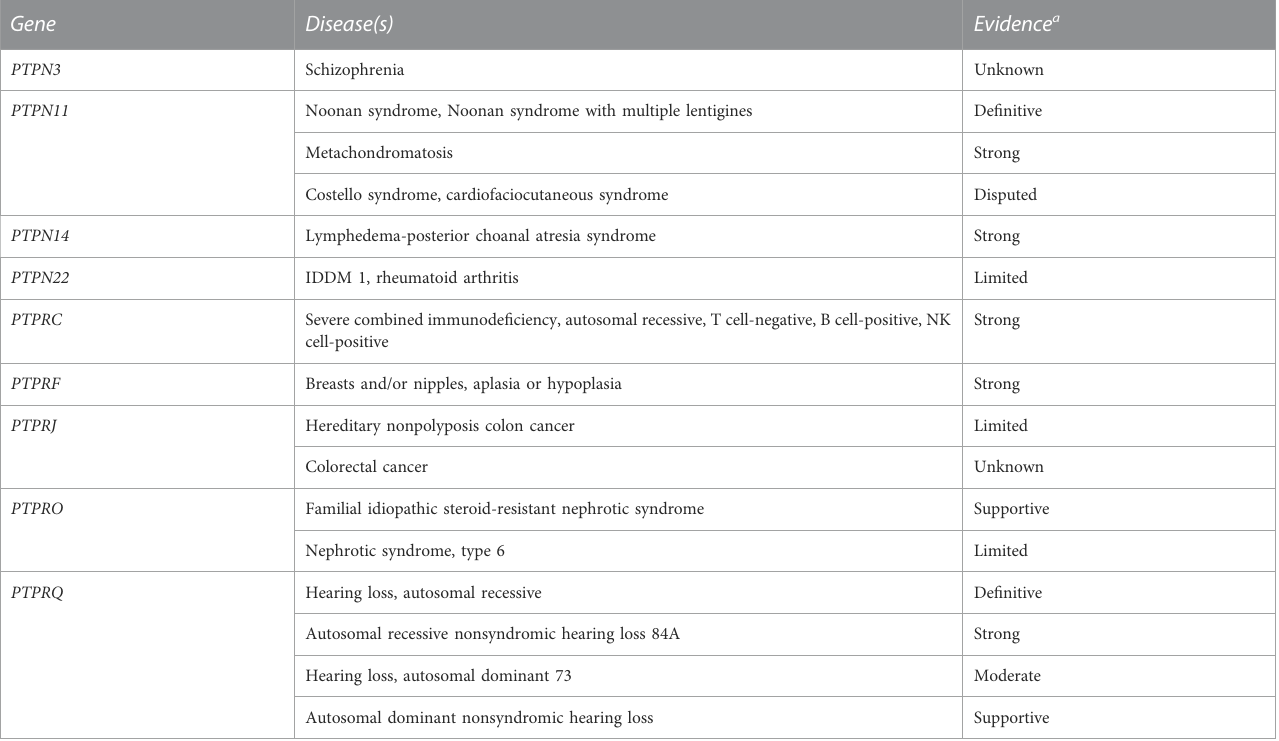
TABLE 1 Curated data for PTP genes in GenCC. Gene